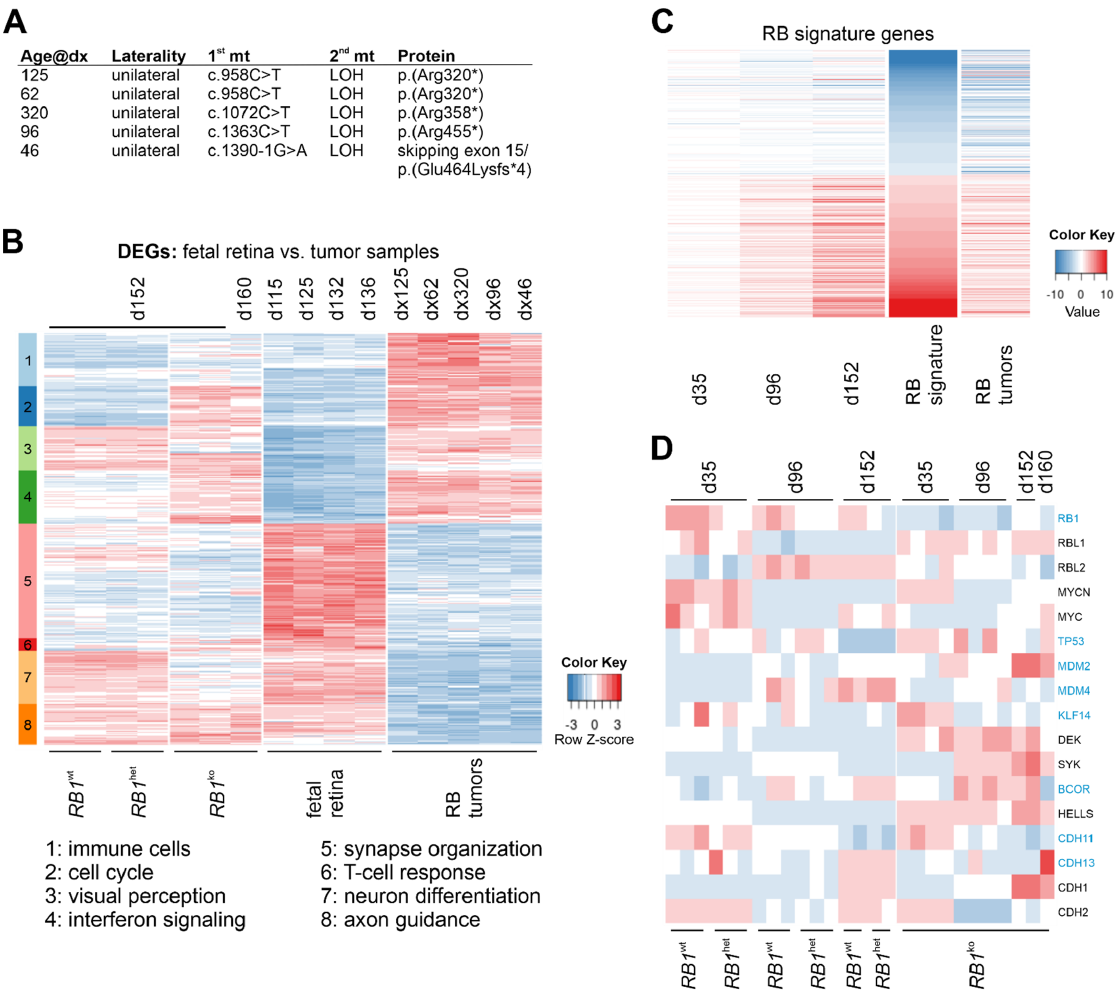
Figure 7. RB1 ko gain retinoblastoma signature during differentiation. ( A ) Data of tumor samples sequenced. Age@dx: age at diagnosis in days after birth; 1st mt/2nd mt: first/second mutation in tumor (note: c.1 is A of ATG start codon of LRG_517t1). ( B ) DEGs were determined between fetal